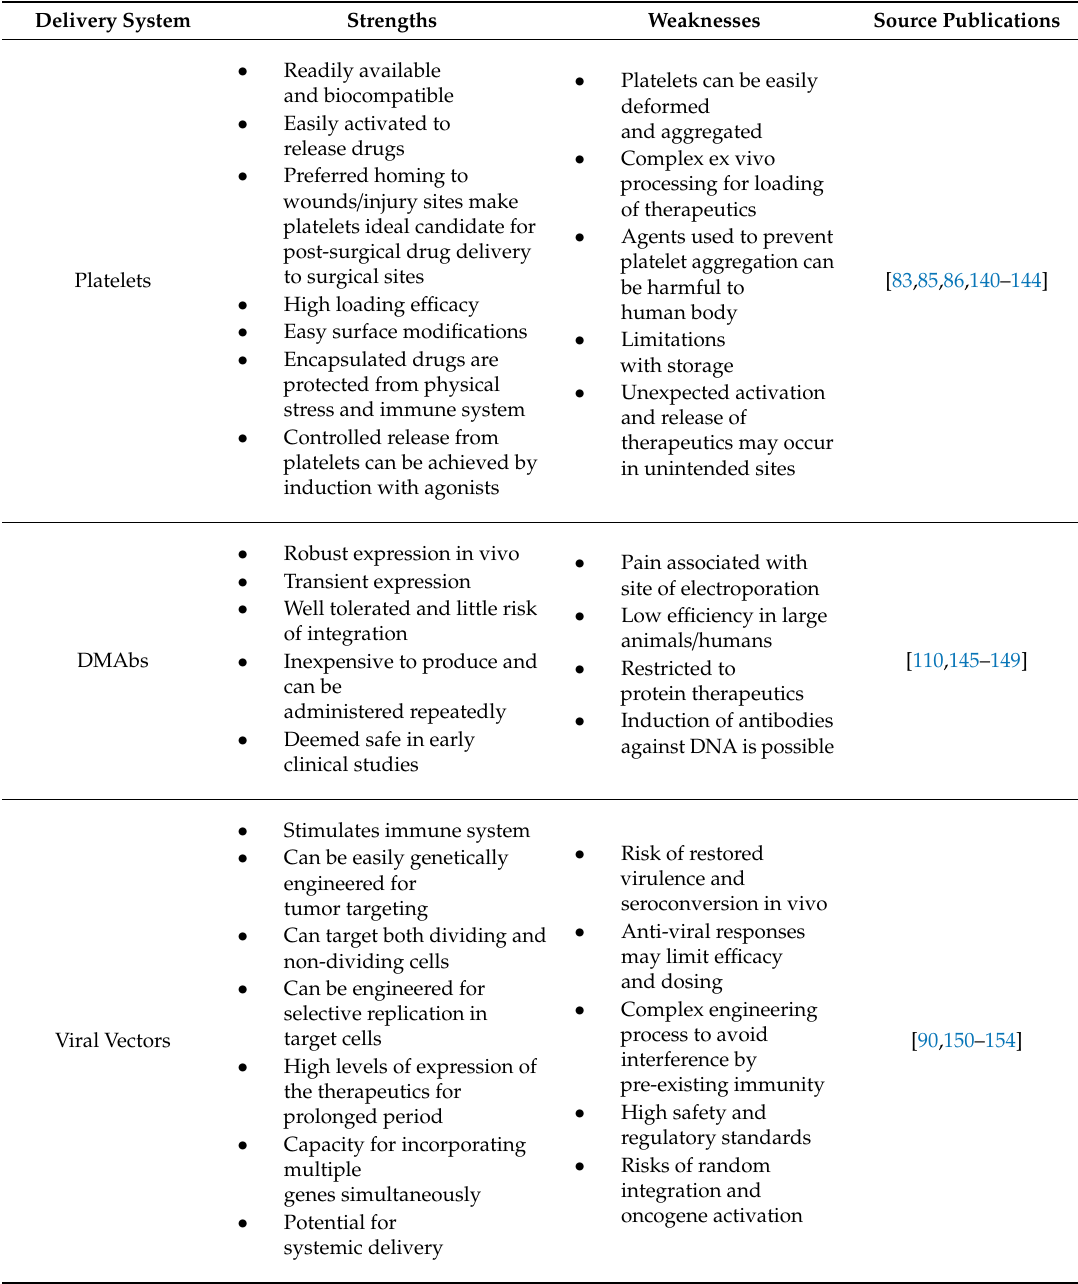
Table 2. Summary of strengths and weaknesses of delivery